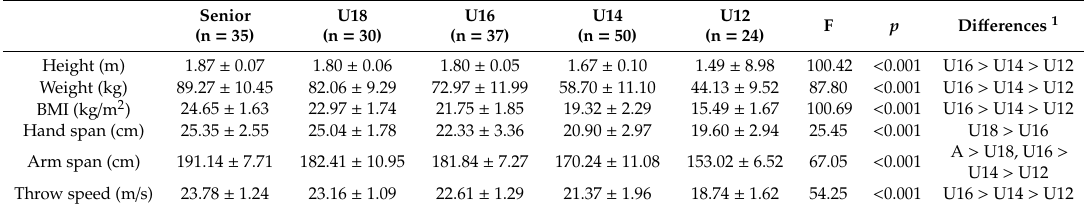
Table 1. Mean (M) and standard deviation (SD) of each variable. A one-way analysis of variance (ANOVA) with Bonferroni post-hot test was used to compare means between groups.